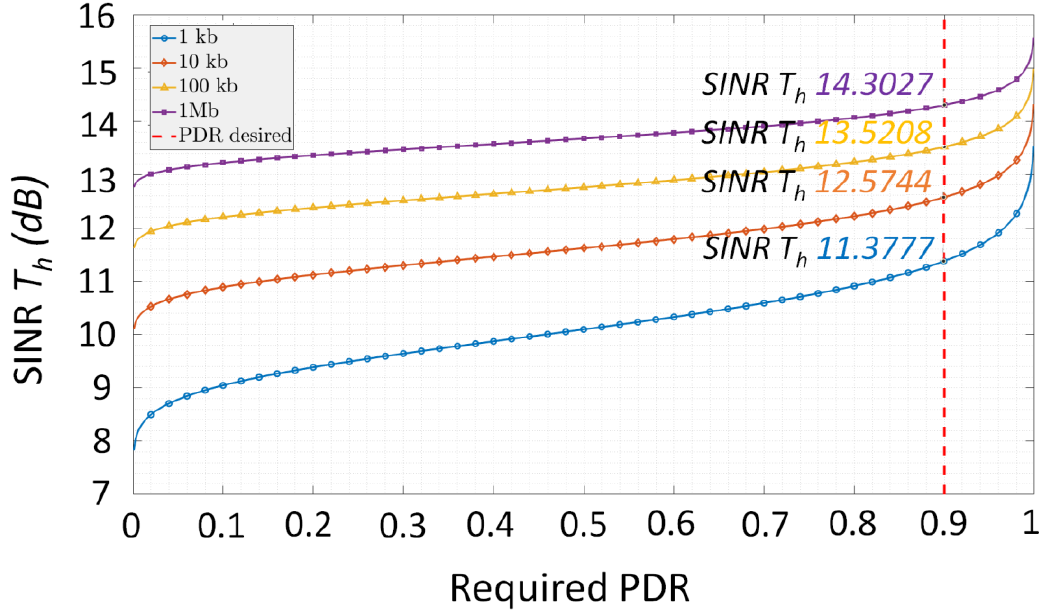
Figure 2. Illustration of the dependency between the required Signal to Interference Noise Ratio threshold with respect to the imposed Packet Delivery Ratio for different packet sizes.